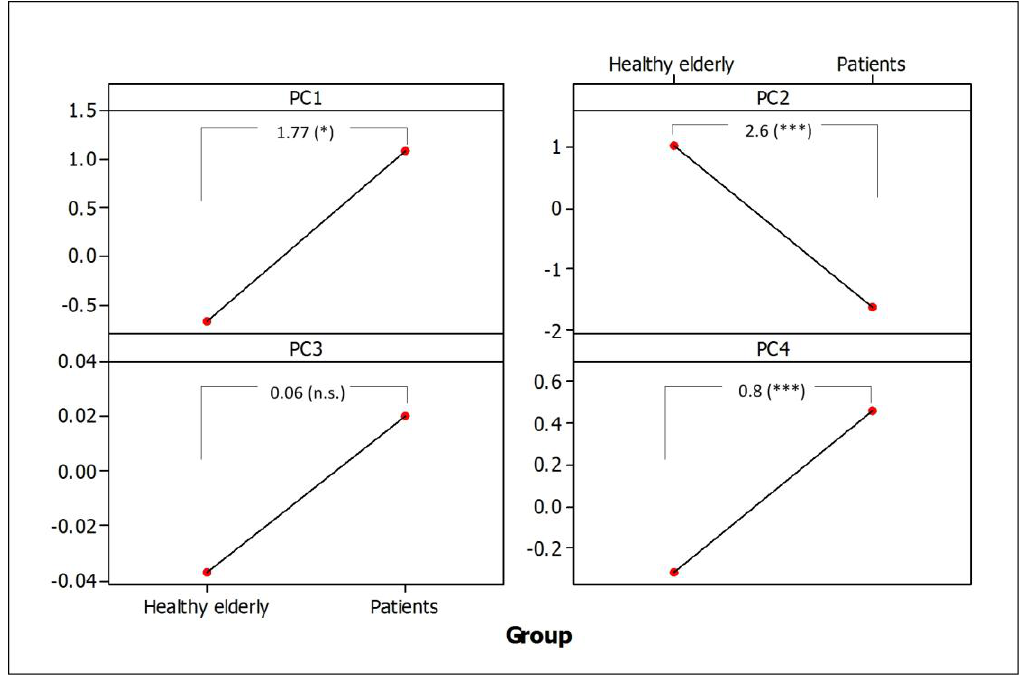
Figure 3. Mean scores of the first four PCs for healthy elderly subjects and PD patients, corrected for within-individual variation using the LME models. Absolute mean differences and P-values are shown with respect to the healthy elderly group. Symbols: * = p < 0.05, *** = p < 0.001, n.s. = not significant. Group: healthy elderly ( n = 876), patients ( n =